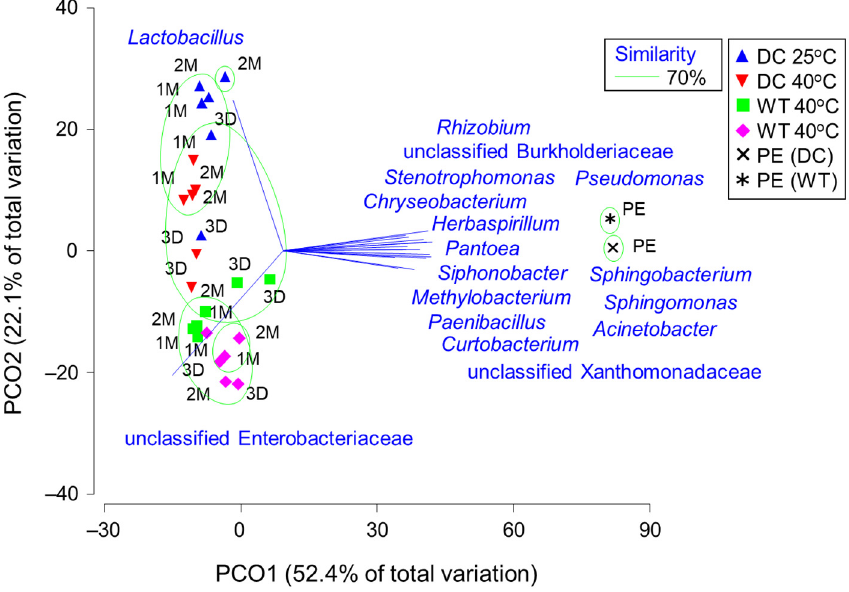
Figure 2. Beta diversity of the bacterial microbiota of pre-ensiled crops and silages prepared from direct-cut and wilted guinea grass. The principal coordinate analysis plot of the Bray-Curtis distance matrix was generated from the filtered genus (relative abundance > 1%). Points that are closer together on the ordination have a more similar microbiota. The operational taxonomy unit with a Pearson’s correlation of >0.7 is overlaid on the plot as vectors. Green circles denote samples enclosed in the same group at a 70% similarity level. PE, DC, WT, 3D, 1M, and 2M indicate pre-ensiled crop, direct-cut silage, wilted silage, silage stored for 3 days, silage stored for 1 month, and silage stored for 2 months, respectively.